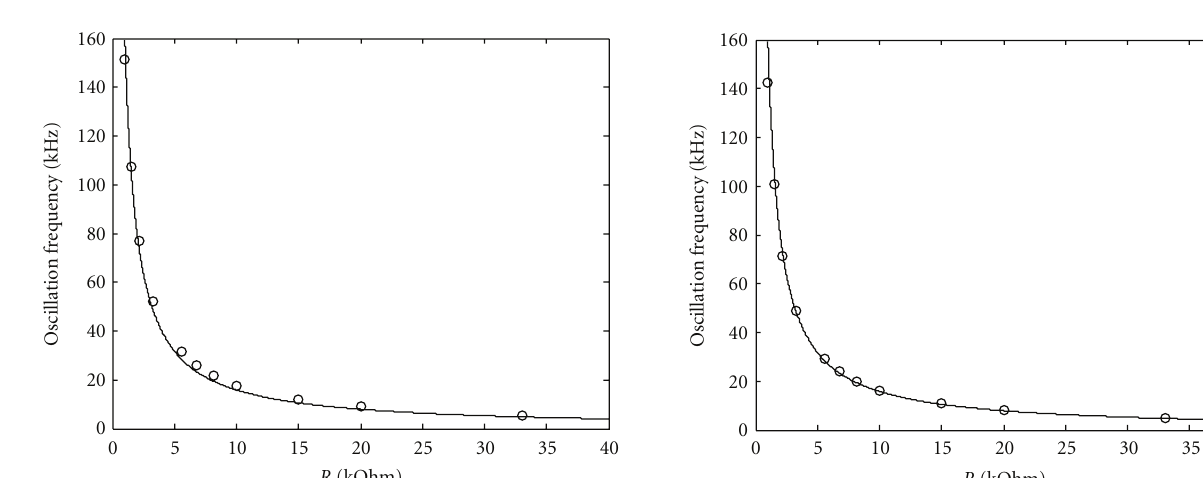
Figure 3: The experimental quadrature output waveforms of Figure 1.